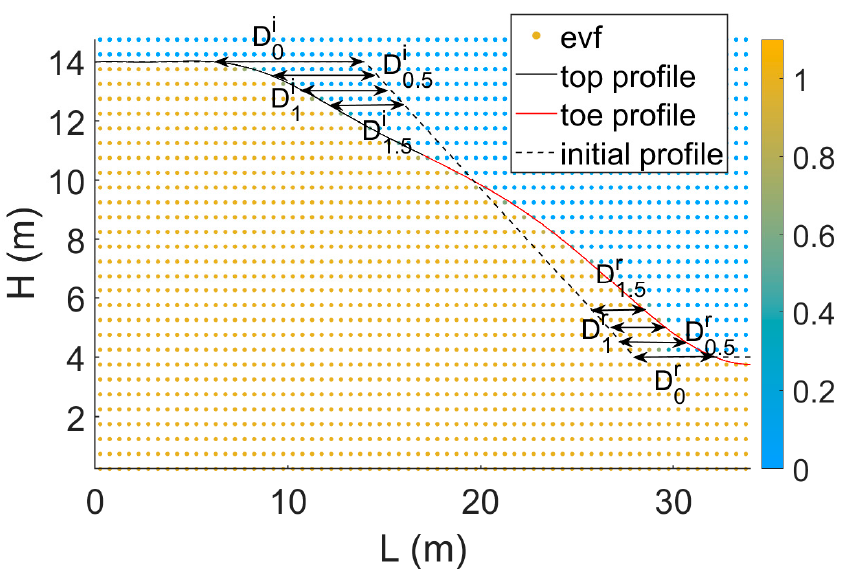
Figure 10. Determination of the slope surface, runout, and influence distance.